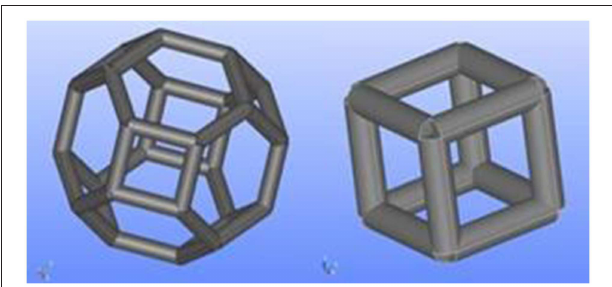
FIGURE 6 | Three-dimensional and frontal view of a Kelvin cell (KC), from Lucci et al. (2014) and a cubic cell from Papetti et al. (2018).